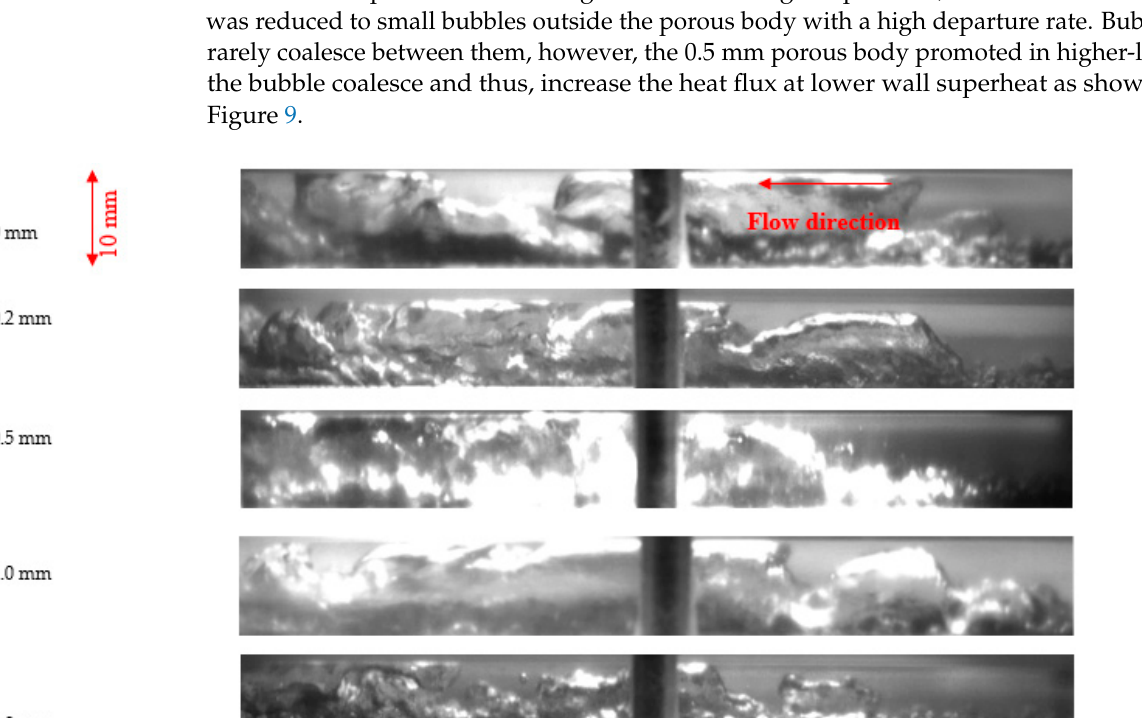
Figure 8. Flow and bubble formation pattern at the maximum heat flux for all the porous thickness: ∆𝑇 (cid:3046)(cid:3048)(cid:3029) = 50 K ; G = 400 kg·m − 2 s − 1 .